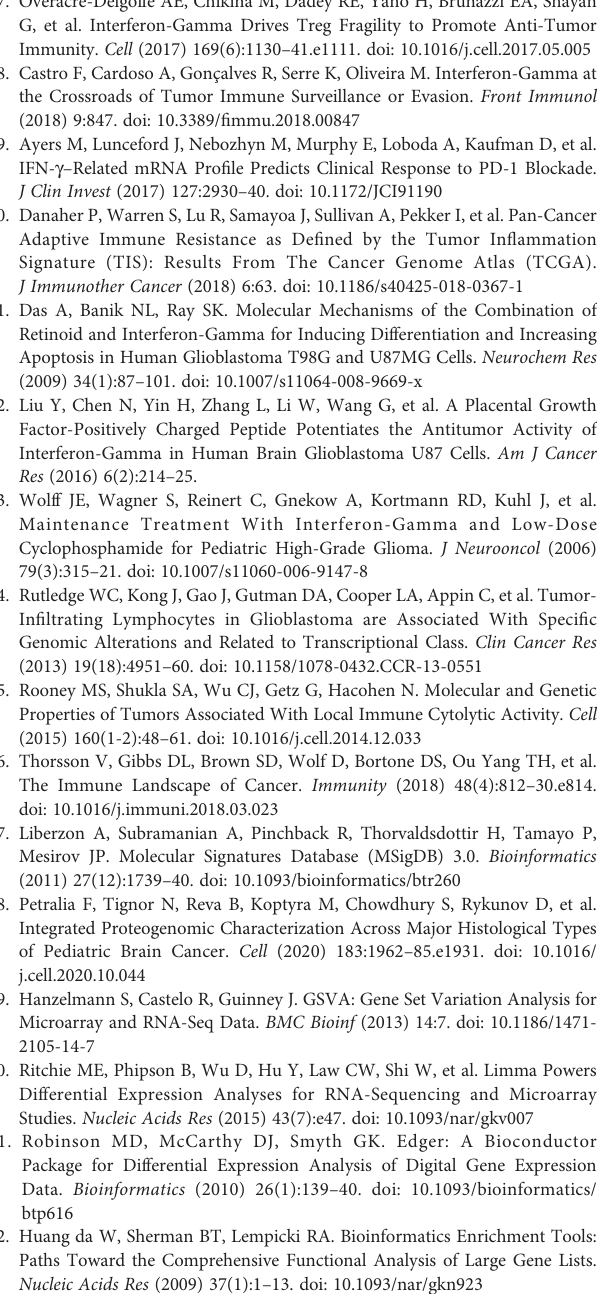
Supplementary Figure 6 | (A – C) The EGFR mutation had heterogeneous prognostic signi fi cance for the IFNGrGS score-high and -low groups. For the IFNGrGS score-low group, EGFR mutation was more of a prognostic risk factor. As for the IFNGrGS score-high group, EGFR mutation was a prognostic protective factor. (D) Signi fi cant ampli fi cation and deletions in copy number. (E) Somatic copy number alteration (SCNA) load between the IFNGrGS score-high and -low groups. (F) The TMB and (G) TNB between the IFNGrGS score-high and -low groups. Supplementary Figure 7 | (A) IFNGrGS-based strati fi cation has prognostic value in CGGA693 (RNA-seq) and Gravendeel (microarray) data sets. The K-M plots of previouslyestablishedpan-cancer-based (B) IFNGgenesignatureand (C) IFNGexpand